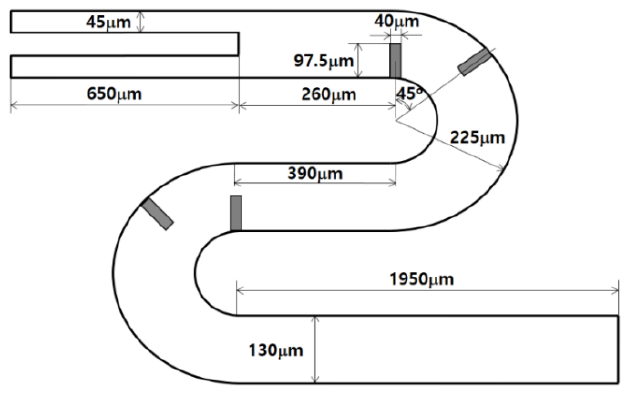
Figure 3. Diagram of the micromixer experimented by Tsai et al. [25].